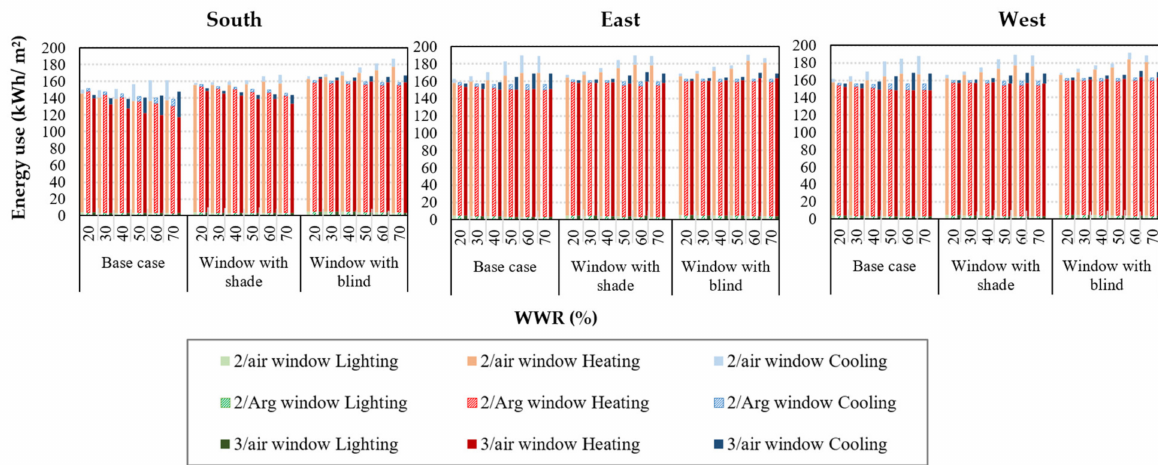
Figure 13. Lighting, cooling, and heating energy use as a function of WWR (%) for three window types (2/air, 2/Arg, and 3/air windows) for south, east and west orientations of buildings located in Snow, fully humid climate with warm summer